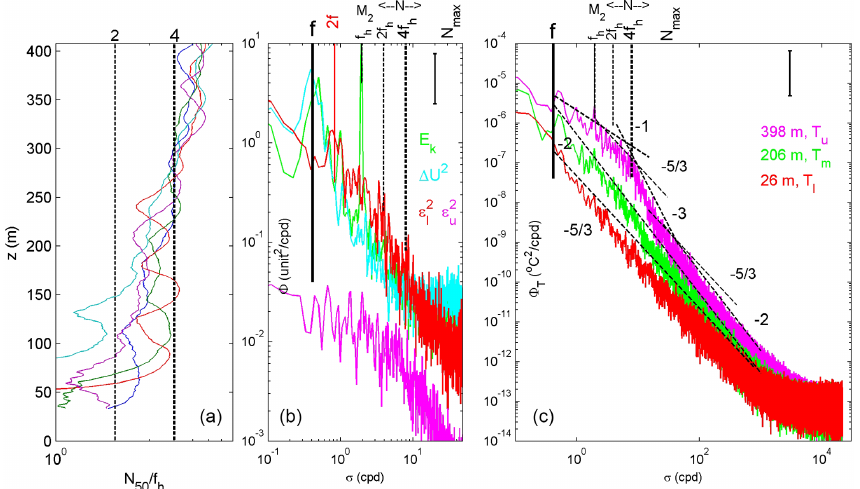
Figure 2. Stratification and spectral overview. (a) Vertical profiles of buoyancy frequency scaled with the local horizontal component of the Coriolis parameter f h and smoothed over 50dbar ( ∼ 50m) from all five CTD stations to within 1km from the mooring. The blue, green and red profiles are made around the time of mooring deployment. (b) Weakly smoothed (10 degrees of freedom, DOF) spectra of kinetic energy (upper current meter; green) and current difference (between upper and middle current meters; light blue). In red and purple are the spectra of 150s subsampled time series of 100m vertically averaged turbulence dissipation rates for the lower (7–107ma.b.) and upper (307–407ma.b.) T-sensor data segments, respectively. The inertial frequency f , f h including several higher harmonics, buoyancy frequency N including range and the semidiurnal lunar tidal frequency M 2 are indicated. N max indicates the maximum small-scale buoyancy frequency. (c) Weakly smoothed (10 DOF) spectra of 2s subsampled temperature data from three heights representing upper, middle and lower levels. For reference, several slopes with frequency are